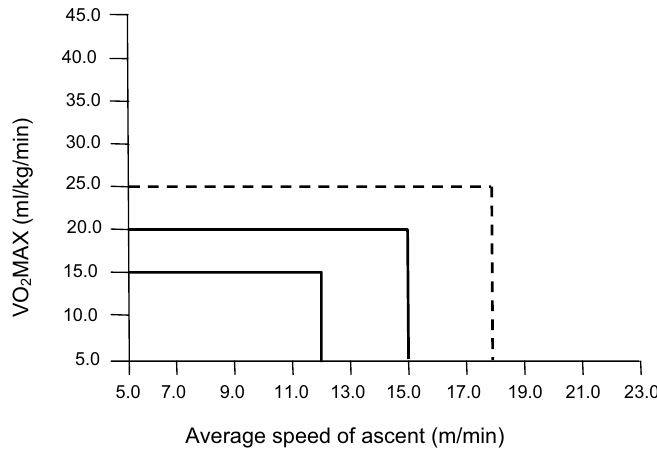
FIGURE 1 - Speed of ascent and VO